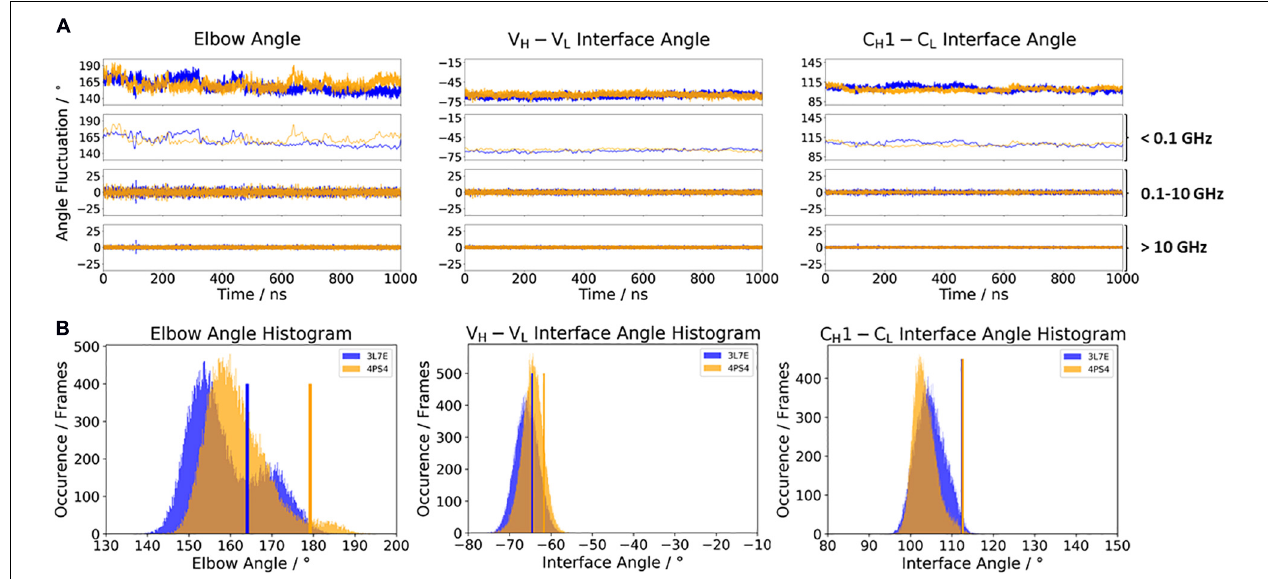
FIGURE 4 | (A) Influence of different framework origins on the relative interface and elbow angle distributions. The chimeric c836 antibody (PDB: 3L7E) is illustrated in blue, while the optimized humanization variant m1295 (PDB: 4PS4) is depicted in orange. The calculations of the FFT of the respective distributions are displayed, showing the angle variations occurring faster than 1 ns, between 0.1 and 10 ns, and slower than 10 ns. (B) Histograms of the respective interface and elbow angle distributions, including the respective X-ray structures of the chimeric and the humanized Fabs, which were used as starting structures for molecular dynamics simulations.